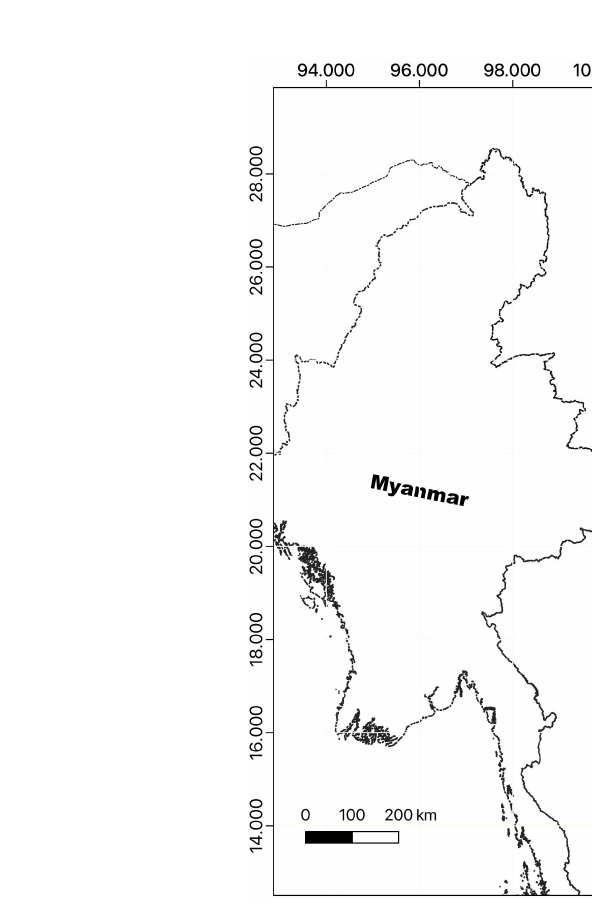
FIGURE 1 The position of the Golden Triangle and Boten special economy zones (SEZs) in Southeast